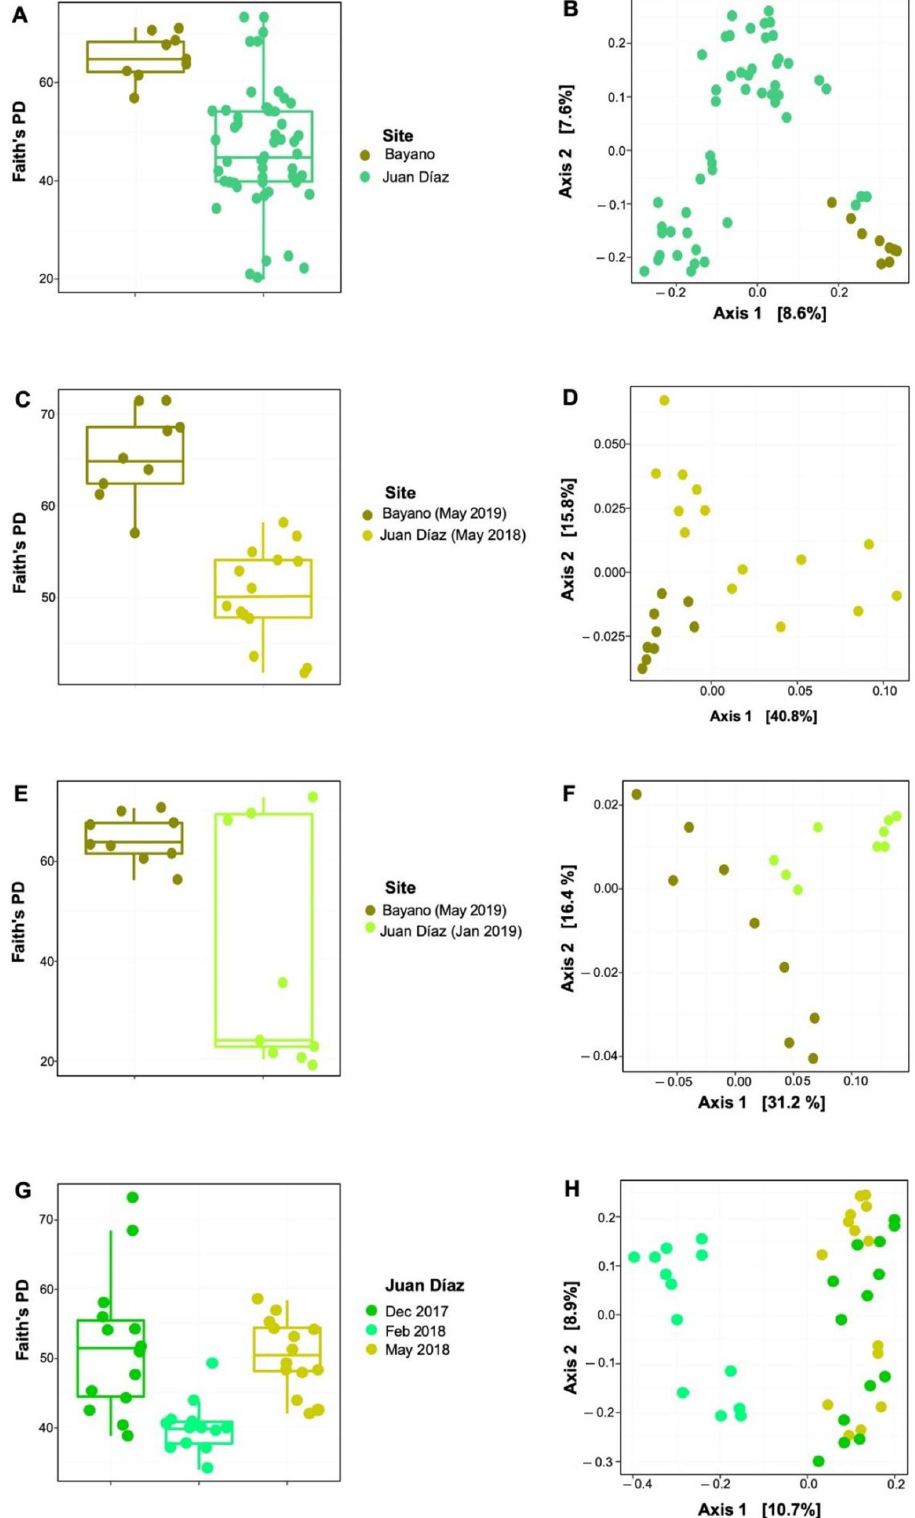
Figure 3. Phylogenetic diversity is higher at the rural and less polluted Bayano mangrove site than in the urban Juan D í az site; and changes through time were higher in the rainy (December and May) season than in the dry season (February). Alpha diversity based on Faith’s phylogenetic diversity for each site ( A ). PCoA based on unweighted Unifrac distance for the two sites ( B ). Alpha diversity based on Faith’s phylogenetic diversity for the two sites using data for one month in different years ( C